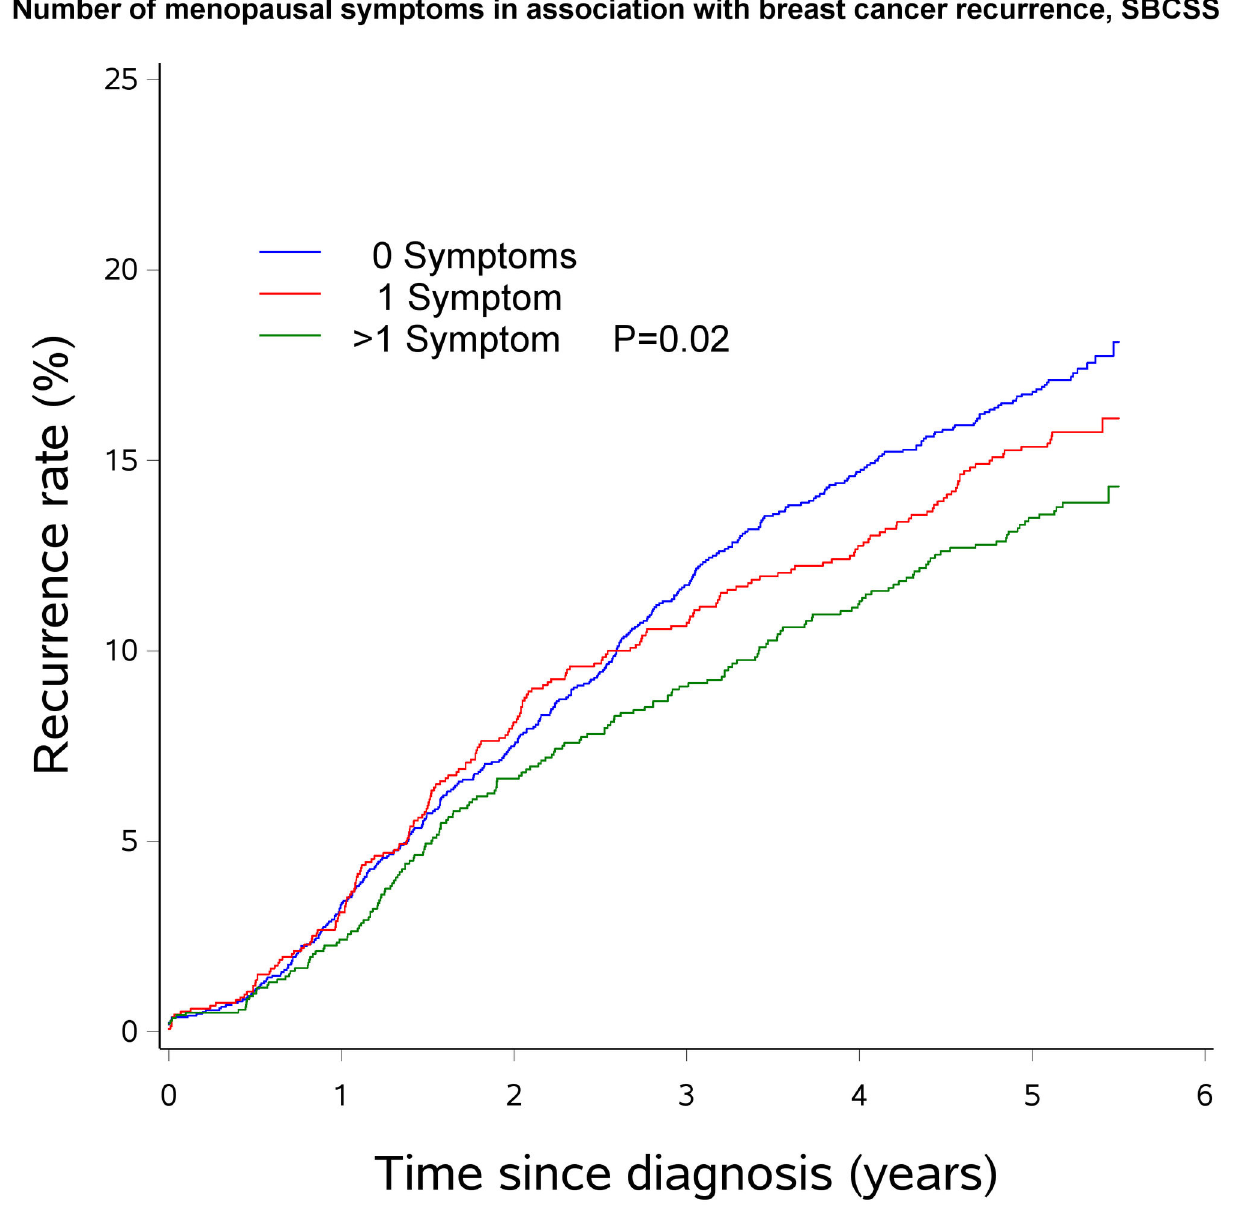
Figure 2. Number of menopausal symptoms in association with breast cancer recurrence, SBCSS.